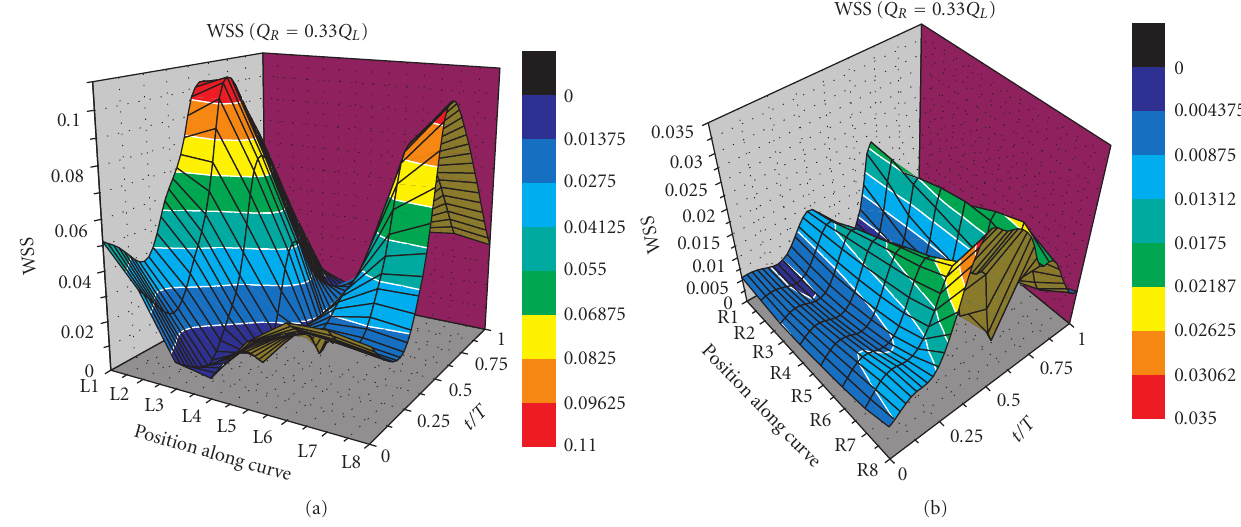
Figure 10: WSS versus position and time for Q R = 0 . 33 Q L on (a) the left and (b) the right bifurcation regions.